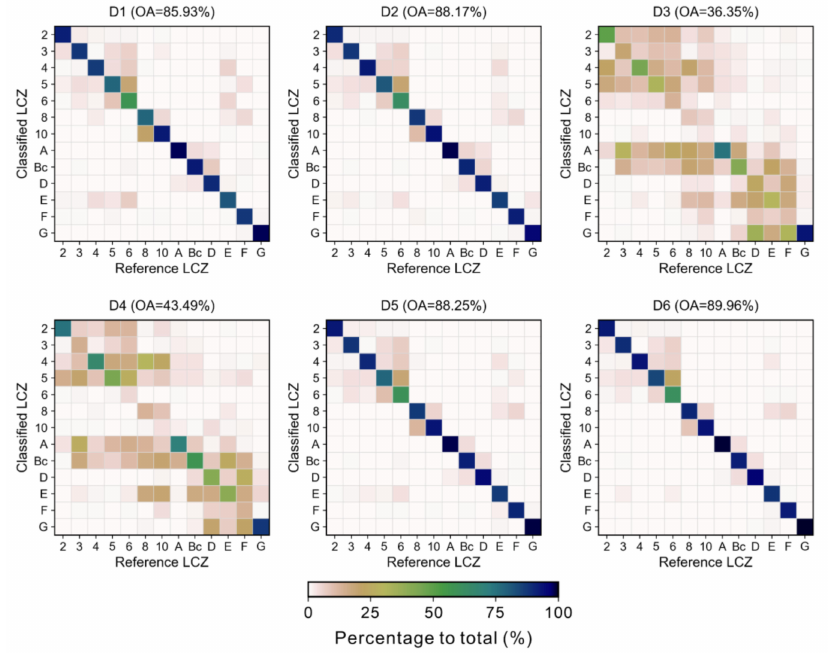
Figure 4. Confusion matrices and overall accuracies (OAs) of LCZ maps obtained by RF classification using different datasets ( D1 – D6 ). The confusion matrices are expressed as percentages to the total number of test pixels.